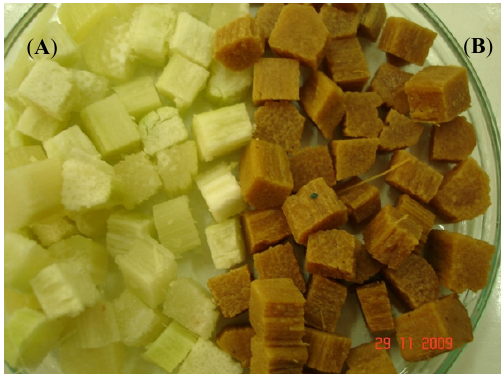
Figure 4. Comparison of sorghum stalk pieces before ( A ) and after ( B ) the ethanol fermentation for the eight successive batches.